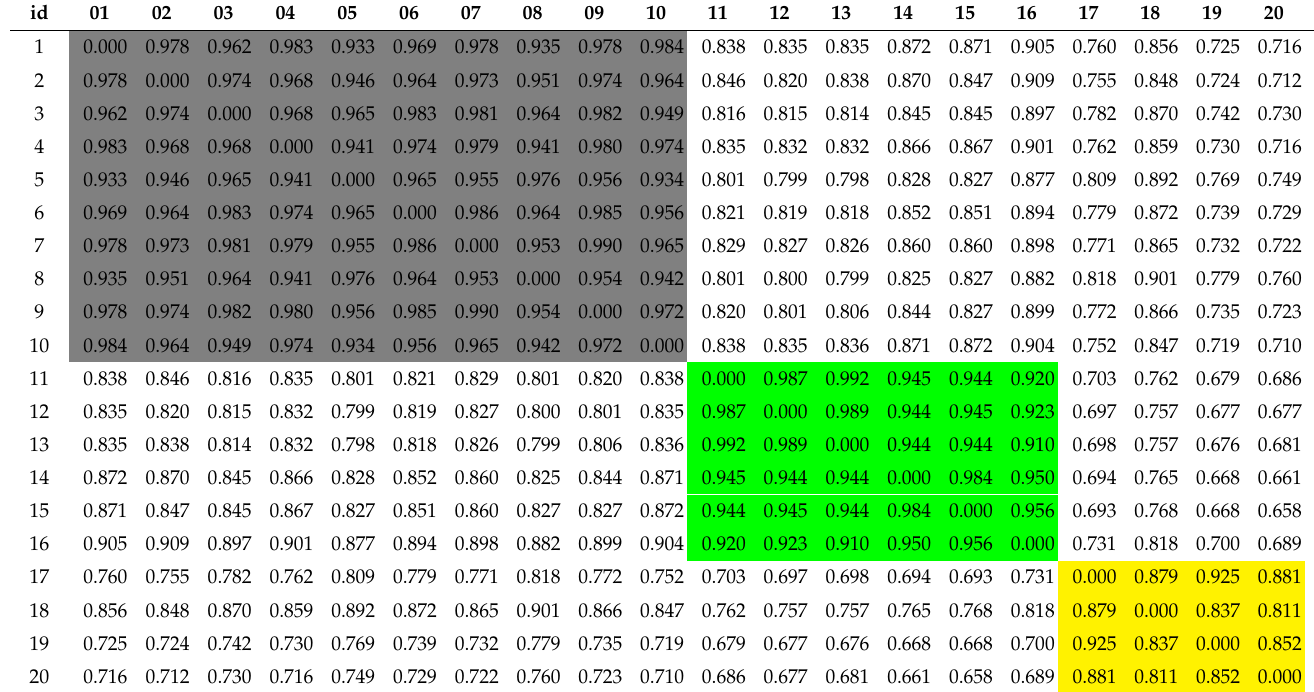
Table 6. The affinity matrix W ABC of voltage sag